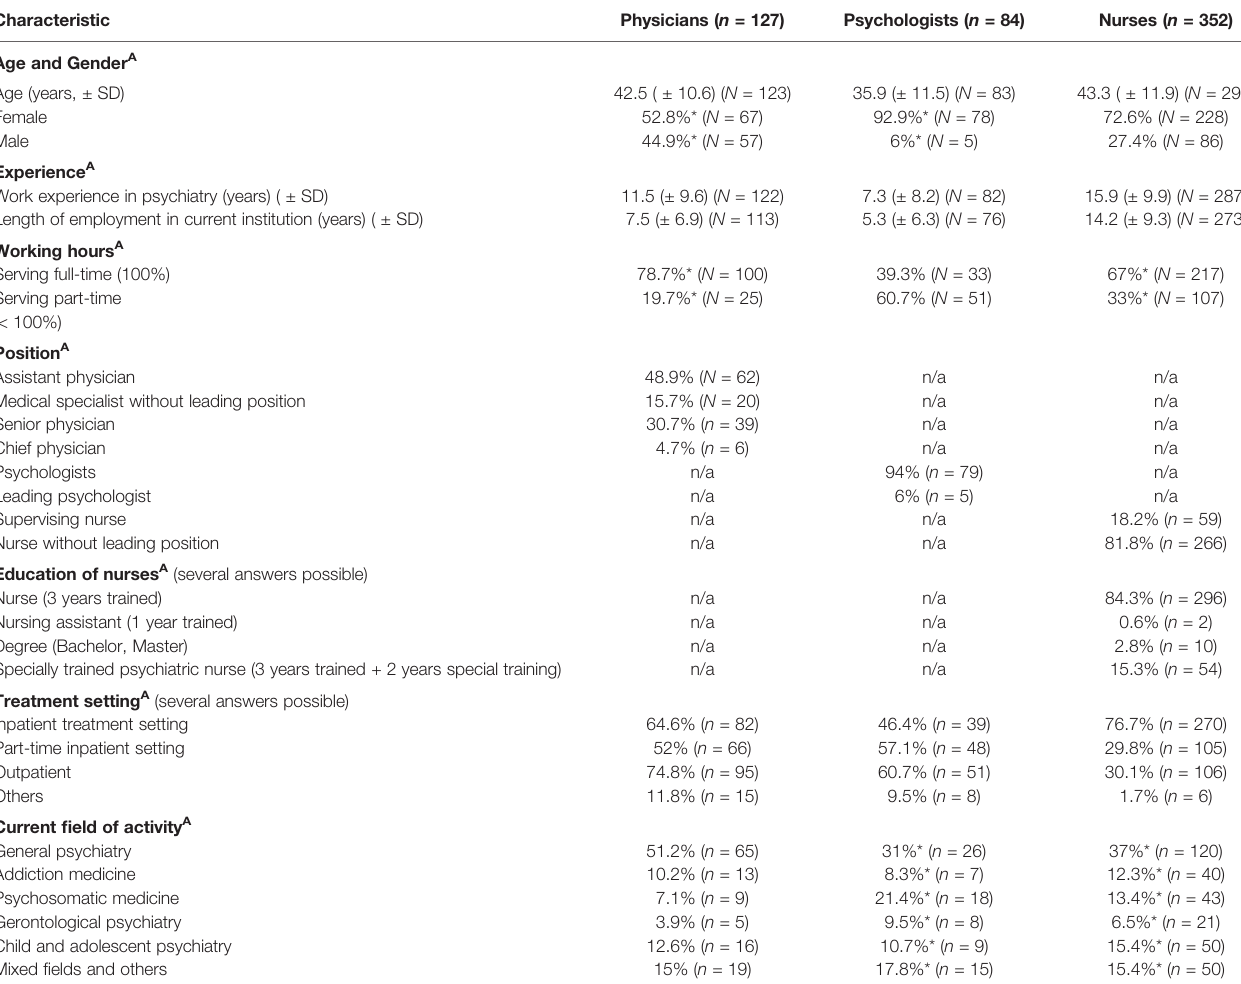
TABLE 1 | Sociodemographic and professional characteristics of